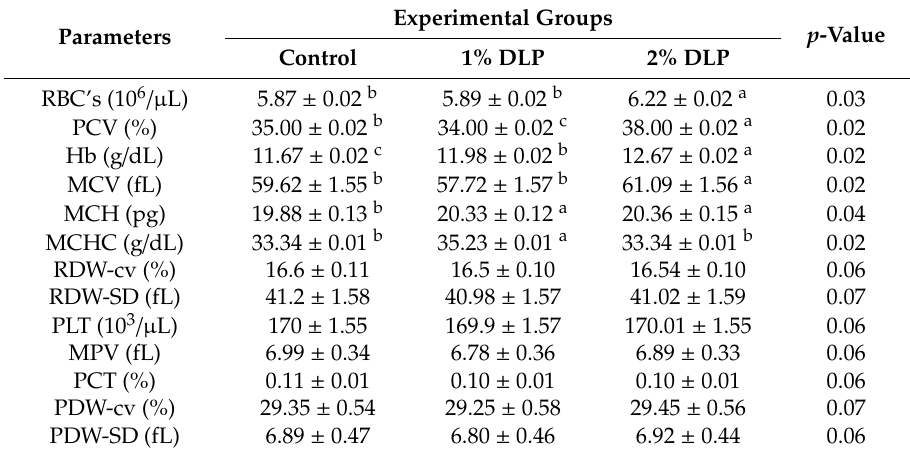
Table 5. The e ff ects of dried lemon supplementation of di ff erent hematological